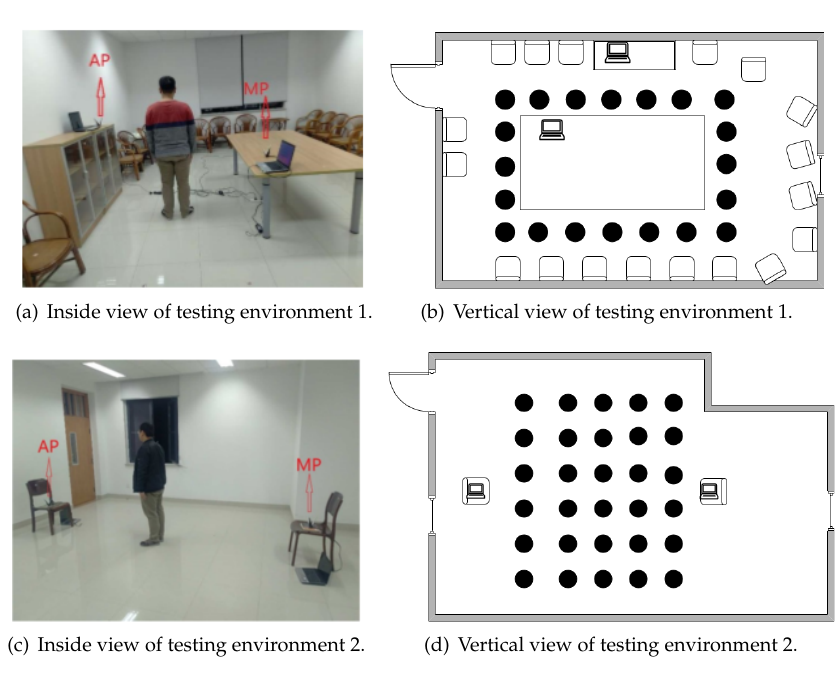
Figure 5. The experiment